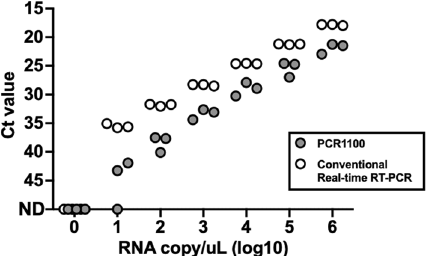
Fig. 2 Limit of detection (LOD) analysis of the PCR1100 assay and conventional real-time RT-PCR. RABV-positive control RNA with a known copy number was tested in triplicate to determine the LOD for both the PCR1100 assay and conventional real-time RT-PCR (CFX connected Real-Time PCR). Protocols for LN34 primer/probe sets were used for the PCR1100 assay and conventional real-time